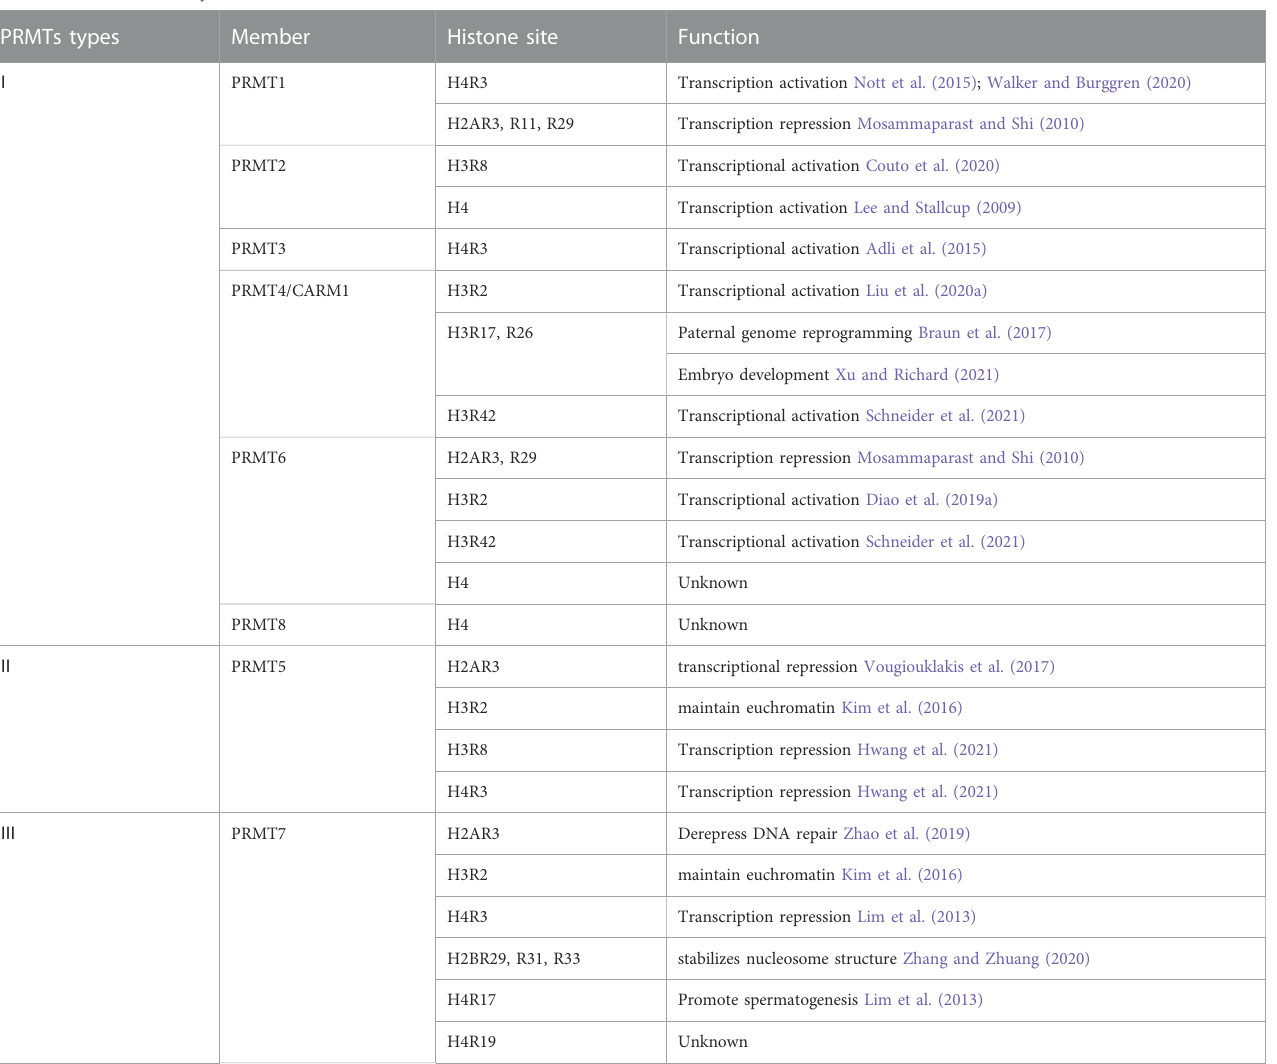
TABLE 1 The histone methylation site of